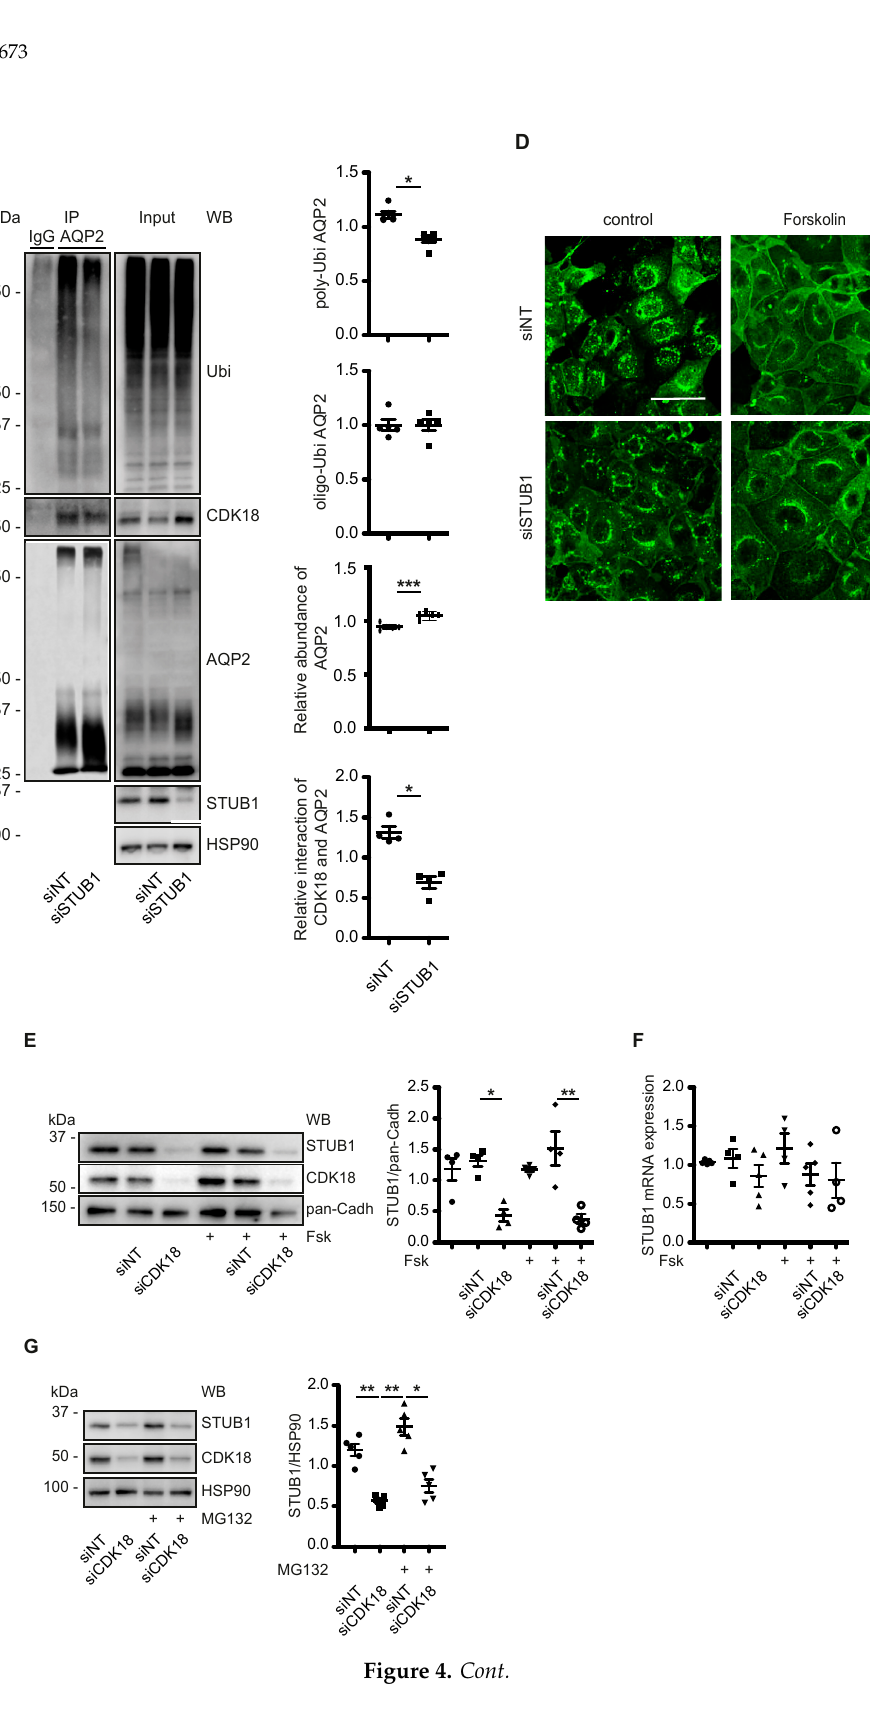
Figure 4. CDK18 regulates STUB1 to control AQP2 ubiquitination, abundance and localisation. ( A ) MCD4 cells were transfected with control non-targeting (siNT) or CDK18 siRNA, lysed and AQP2 was immunoprecipitated (IP). As a control, unrelated IgG was used (IgG). AQP2 and co- immunoprecipitated ubiquitin (Ubi) were detected by Western blotting (WB). Shown are a representative result from n = 4 independent experiments including the input samples where HSP90 was used as a loading control. The signals were semi-quantitatively analyzed by densitometry. Ubiquitin signals larger than 50 kDa were considered as poly-Ubiquitination, while under 50 kDa as oligo-Ubiquitination [25]. ( B ) CDK18-FLAG kinase dead (K150R) or constitutively active (S12D)- encoding constructs were expressed in MCD4 cells, immunoprecipitated through their Flag tags and the interactomes analysed by mass-spectrometry. The x -axis indicates the abundance ratios of the identified interacting proteins of K150R (negative values) versus S12D (positive values). The y -axis represents the significance of a two-sample moderated t-test by which the proteins were quantified. The dashed line indicates the 5% FDR cut-off based on Benjamini–Hochberg corrected p -values. The identified STUB1 (green) and protein phosphatases (PP, red) subunits are highlighted. ( C ) MCD4 cells were transfected with NT or STUB1 siRNA, lysed and subjected to immunoprecipitation (IP) with anti-AQP2 or control (IgG) antibodies. AQP2, CDK18, STUB1, and in the input samples HSP90 as loading control were detected by Western blotting. Shown are representative results and the densitometric semi-quantitative analysis from n = 4 independent experiments. Ubiquitin (Ubi) signals larger than 50 kDa were considered poly-Ubiquitination, while the ones under 50 kDa were defined as oligo-Ubiquitination [25]. ( D ) Detection of AQP2 (green) by immunofluorescence microscopic analysis of MCD4 cells transfected with siNT or STUB1 siRNA, and stimulated with forskolin (Fsk)